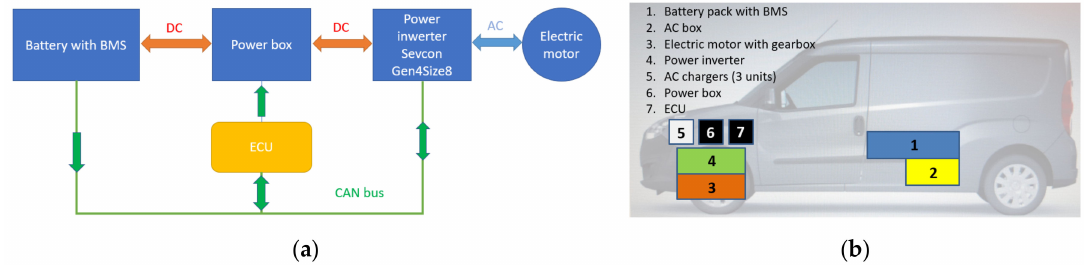
Figure 2. ( a ) Electric energy flow layout and ( b ) main components location in the